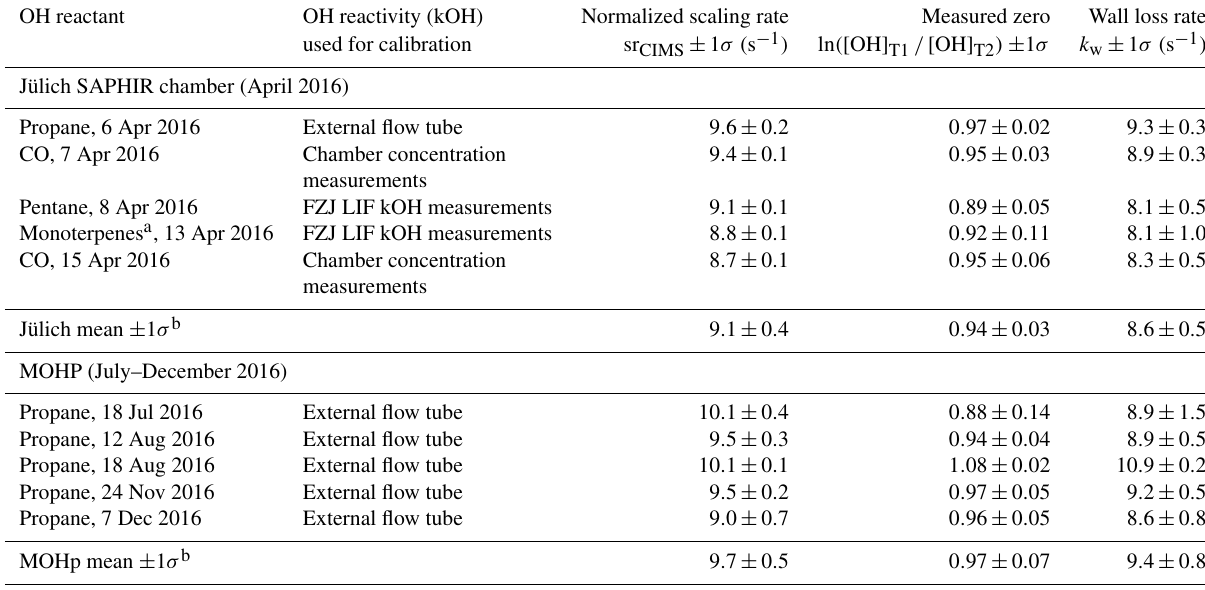
Table 3. Summary of scaling rate sr CIMS and wall loss k w parameters determined from OH reactivity instrument comparison campaign. All sr CIMS values have been normalized using temperature and pressure to allow comparison between Jülich and MOHp